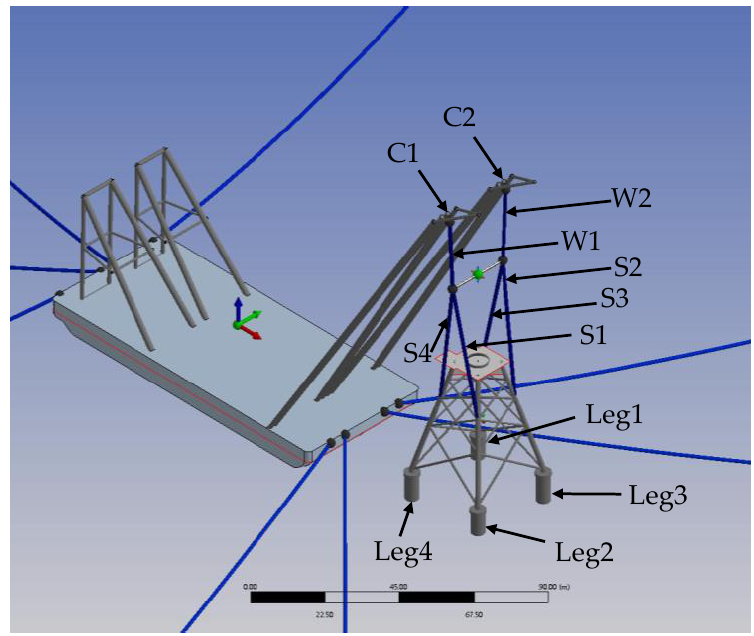
Figure 8. Time- d omain simulation model and lifting system arrangement. Figure 8. Time-domain simulation model and lifting system arrangement. Table 5. Environmental conditions for time-domain simulations.